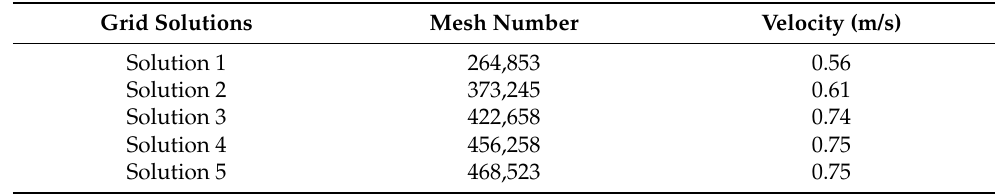
Table 2. Grid independence